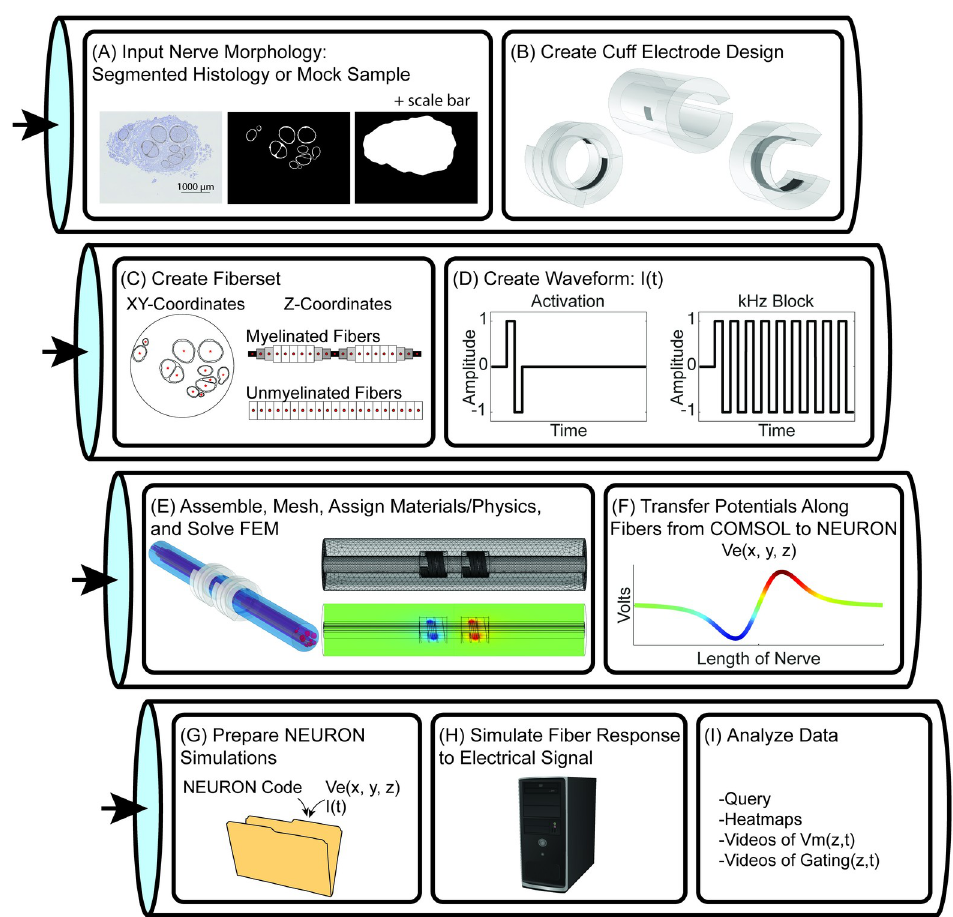
Fig 1. Overview of the ASCENT pipeline for simulating the response of sample-specific nerves to electrical stimulation with custom cuff electrodes and stimulation waveforms. FEM: finite element model.